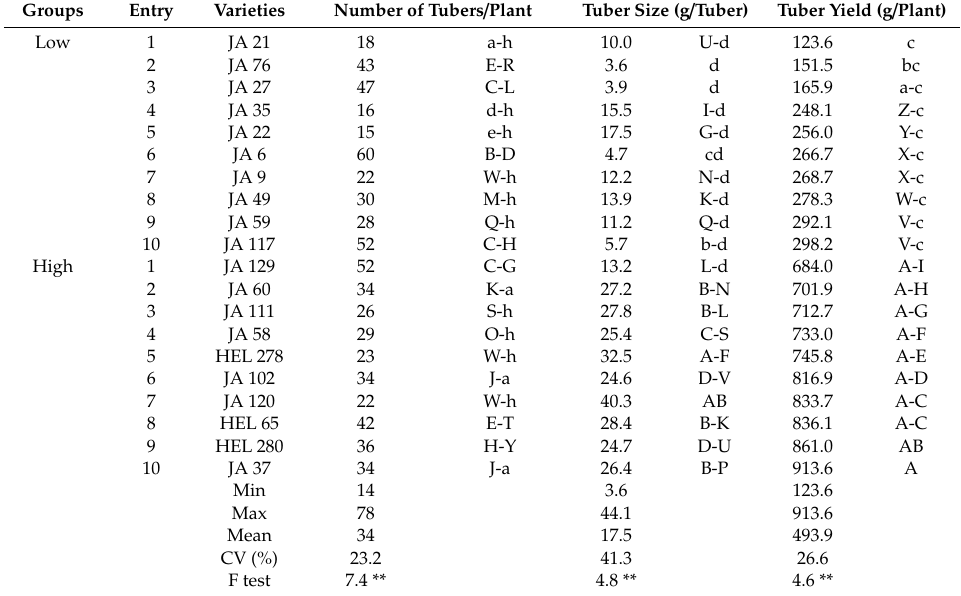
Table 6. Selected varieties of yield and yield component Jerusalem artichoke evaluated in late rainy season.